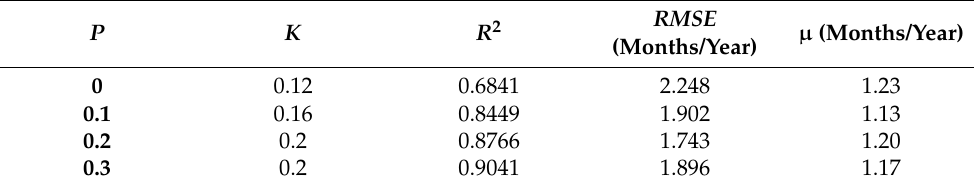
Table 3. Performance indices ( RMSE , R 2 , and mean μ ) for the monthly LDR-equivalent climate. P K R 2